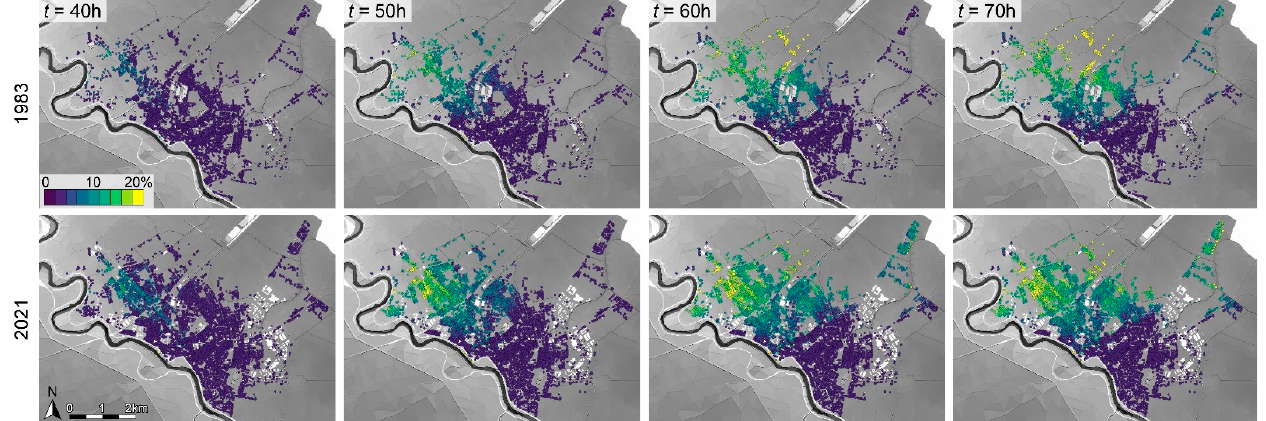
Figure 8. Spatial distribution of the relative damage to residential buildings referred to the ground floor, nf B · D REL , during the flooding event for the layout of 1983 ( upper panels) and of 2021 ( lower panels). Dots correspond to single buildings.